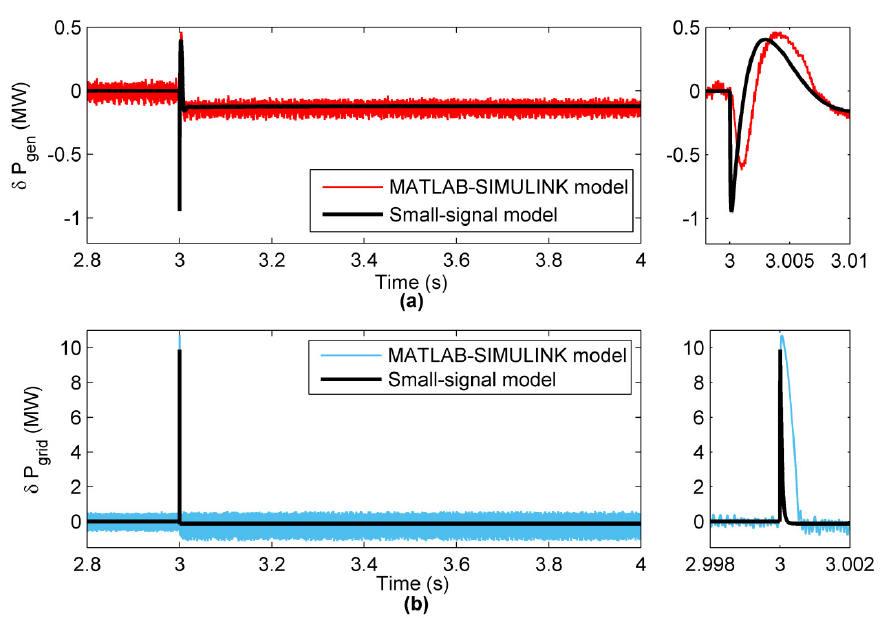
Figure 14. ( a ) The waveforms of generator speed; and ( b ) the d-axis current of the generator ( δ i df ) in a 50% voltage drop at PCC.